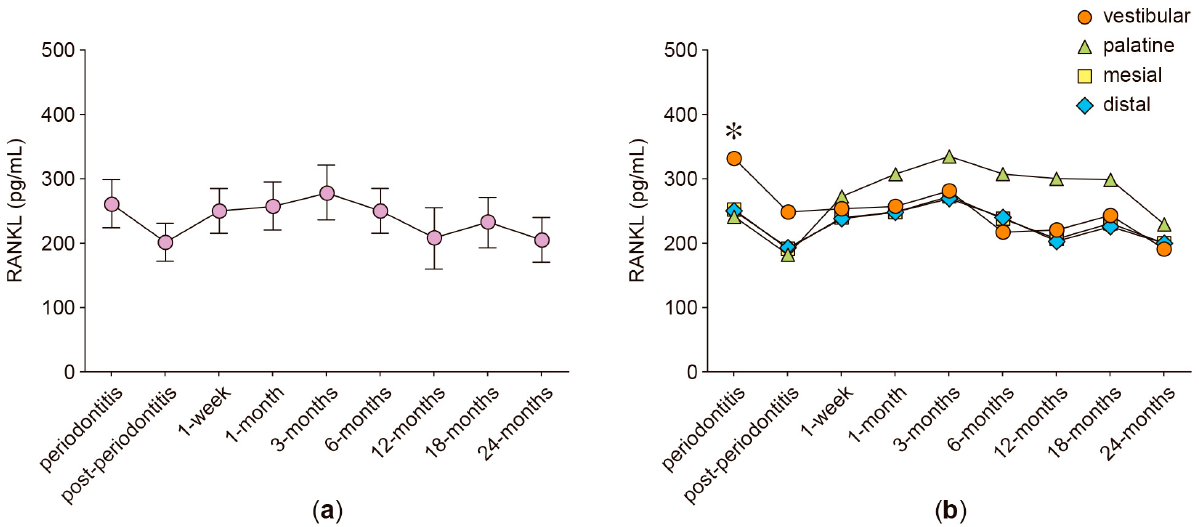
Figure 1. RANKL levels. ( a ) RANKL levels detected in the gingival crevicular fluid of periodontally compromised anterior teeth before periodontitis treatment (periodontitis), after periodontitis treat- ment (post-periodontitis), and during 2 years of patient-specific orthodontic treatment (1 week to 24 months), using intermittent low-intensity orthodontic forces. Data are represented as pg/mL and are shown as mean ± SD. ( b ) RANKL levels detected in each periodontal site, analyzed at the same time-points described in ( a ). * p < 0.05 at periodontitis examination, comparing the vestibular site with the other periodontal sites.